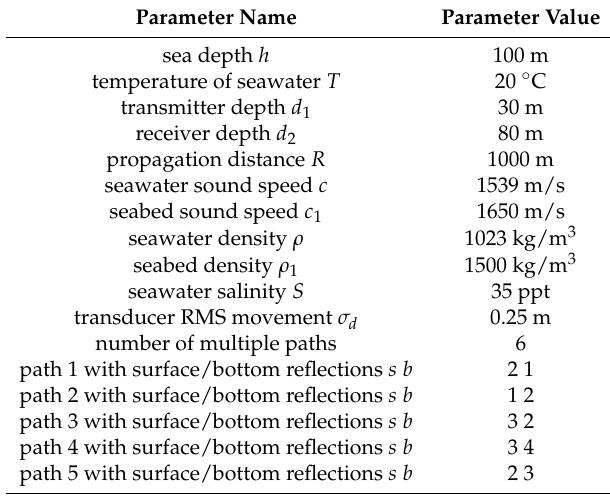
Table A1. Parameters for the underwater acoustic